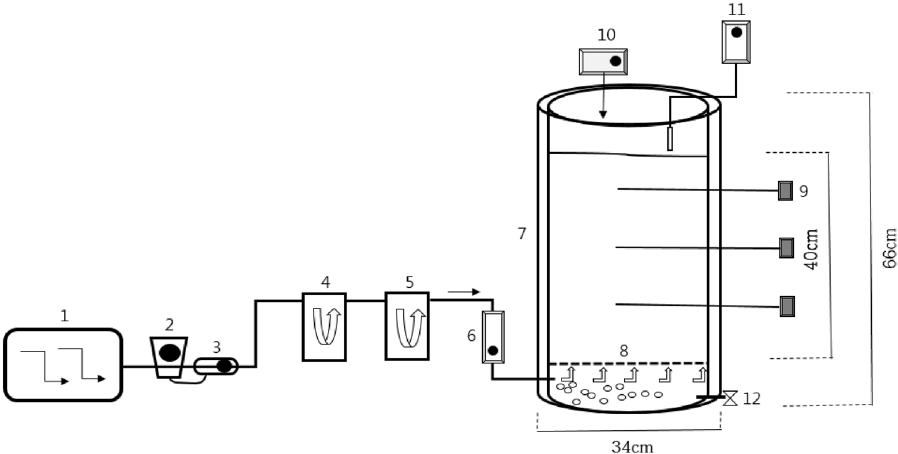
Fig. 1 Schematic diagram of a reactor with experimental apparatus. 1, air compressor; 2, solenoid valve; 3, timer; 4, gas‑washing bottle (solution of NaOH); 5, gas‑washing bottle (distilled water); 6, airflow meter; 7, reactor with insula‑ tion; 8, perforated plate; 9, temperature probe; 10, ammo‑ nia sensor; 11, carbon dioxide sensor; 12, leachate